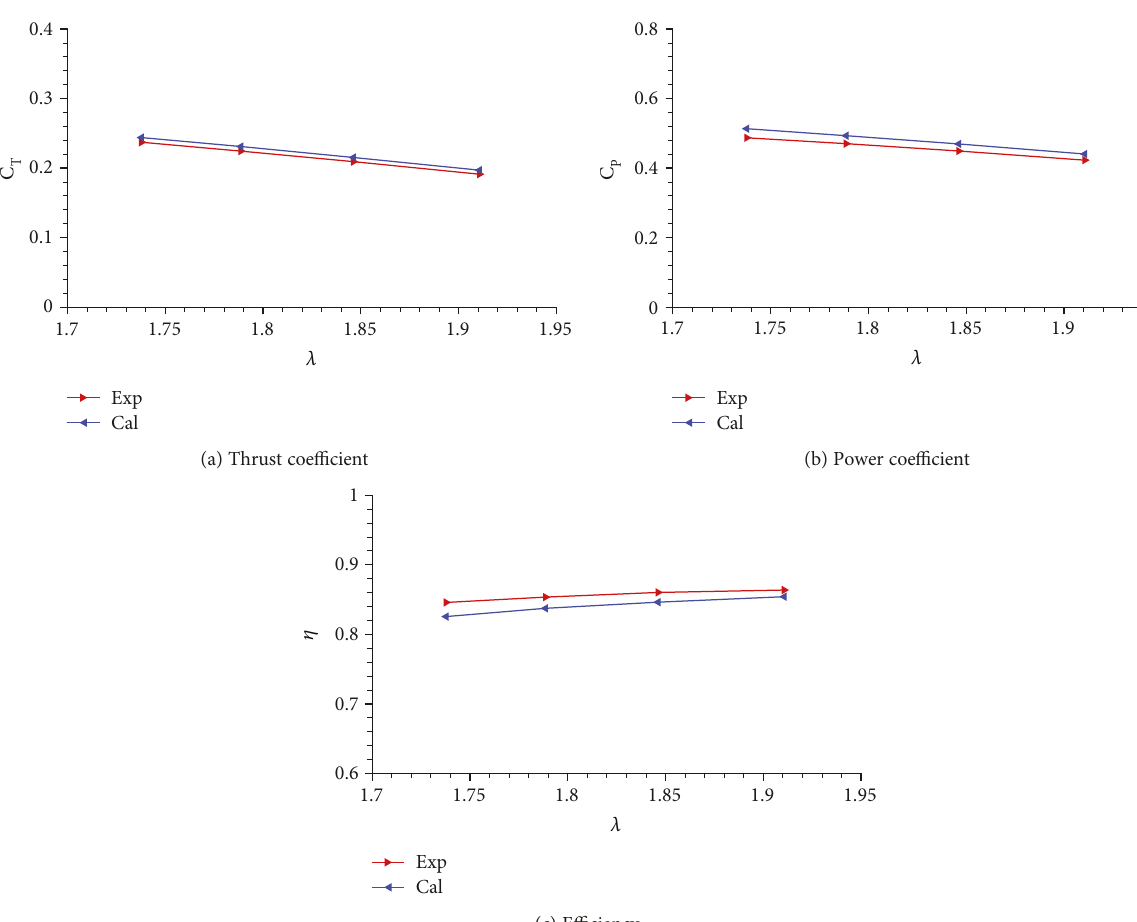
Figure 7: Comparison of propeller performance between the wind tunnel test and URANS